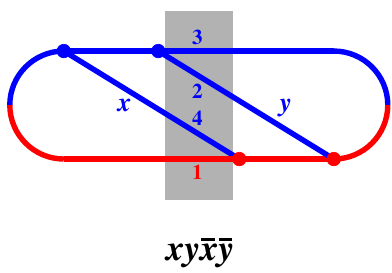
Figure 8 . The canonical “sequential” diagram for which finite- N corrections must be calculated. Above ( t , t , t , t ) are the times of the four vertices in figure 8 from left (earliest) to x y ¯x ¯y right (latest). The factors h B y , t | B x , t i and h B ¯y , t | B ¯x , t i represent the propagators y x ¯y ¯x for the 3-particle evolution respectively before and after the shaded region of the figure. The factor h C ¯x , C ¯x , t | C y , C y , t i represents the propagator for the 4-particle evolution ¯x y 41 23 41 23 inside of the shaded region. There is a gradient ∇ (corresponding to a factor of transverse momentum) associated with each splitting vertex. We have not shown here other over- all factors, including how those gradients are contracted together by helicity-dependent DGLAP splitting